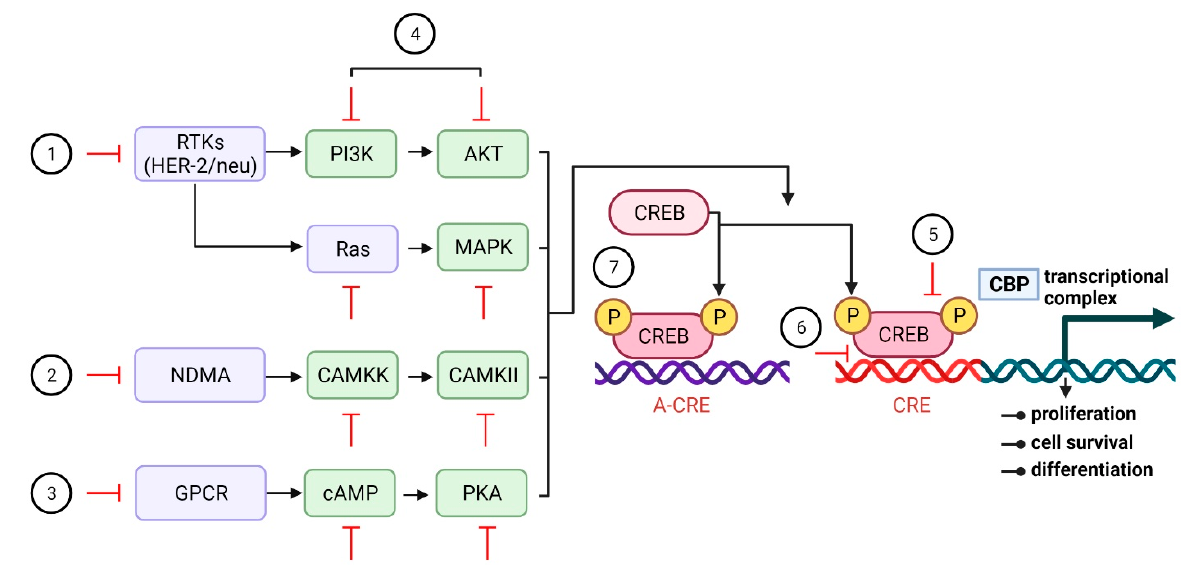
Figure 6. Methods for suppressing CREB expression. A variety of methods have been used in vitro and in vivo to reduce or abrogate CREB expression and activity: 1. Trastuzumab and lapatinib are upstream CREB inhibitors that block HER-2/neu and EGF-R (receptor tyrosine kinases), respectively. 2. Ketamine-induced suppression of ion transporters such as NMDA. 3. Use of beta blockers to inhibit G-protein-coupled receptors. 4. Distinct signal transduction inhibitors are used to examine kinase or substrate activity. 5. KG-501 prevents CREB from interacting with coactivators CBP/p300. 6. Utilizing surfen hydrate to influence CREB binding at the CRE site. 7. Employing a replica CRE element to limit CREB interaction with the gene promoter. Epidermal growth factor receptor, EGF-R; N-methyl-D-aspartate, NMDA; CREB, cAMP responsive element-binding protein; KG-501, 2-naphthol-AS-E-phosphate; CRE, cAMP response element.